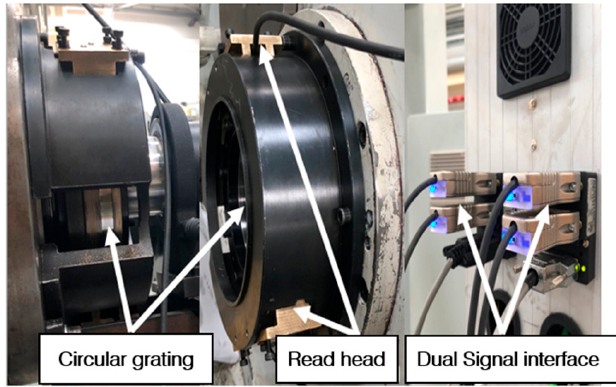
Figure 19. Main components of circular grating equipment.